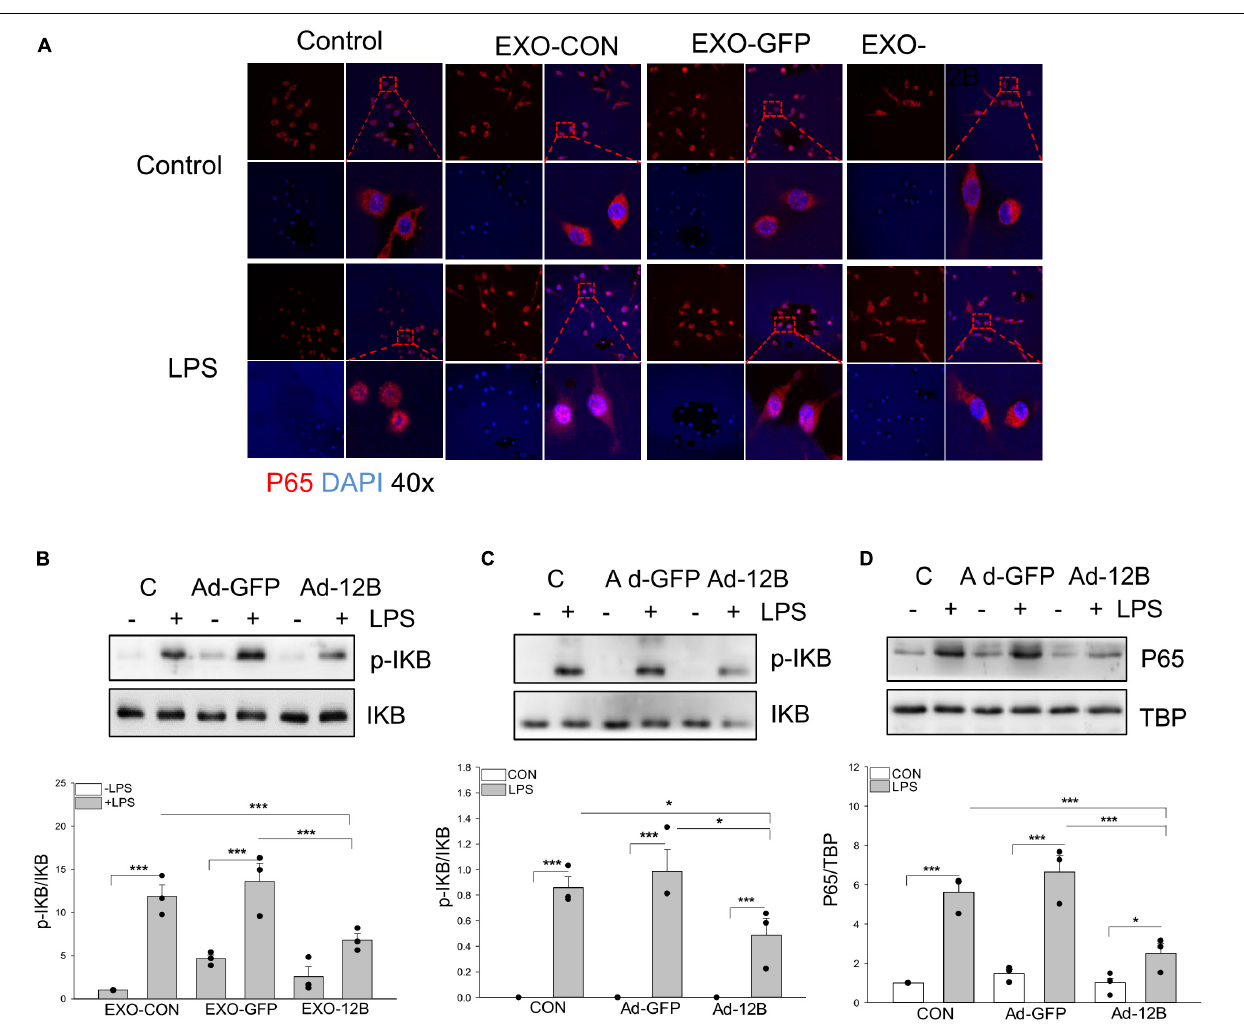
FIGURE 7 | Endothelial exosomes that contain high levels of HSPA12B altered NF- κ B activation in LPS stimulated macrophages. Exosomes were isolated from HEVECs that were transfected with Ad-HSPA12B or Ad-GFP followed by LPS stimulation. Macrophages (RAW 264.7) were incubated with the isolated exosomes for 2 h prior to LPS (1 µ g/ml) stimulation for 1 h. (A) Immunostaining of NF- κ B subunit p65 (red) nuclear translocation. The nucleus was stained with DAPI (blue). (B) Macrophages (RAW 264.7) were incubated with the endothelial exosomes (5 µ g/ml) for 8 h followed by LPS stimulation for 1 h. Phosphorylated I κ B α and total I κ B α were assessed with Western blot. (C,D) Macrophages (Raw 264.7) were transfected with Ad-HSPA12B or Ad-GFP for 6 h by K2 transfection system then changed with fresh medium overnight before the cells were stimulated with LPS (1 µ g/ml) for 1 h. Western blot analysis of the levels of phosphorylated I κ B α and total I κ B α in the cytoplasm and NF- κ B subunit p65 levels in the nucleus. N = 3 ∼ 4/group. * P < 0.05 and *** P < 0.001 compared with indicated